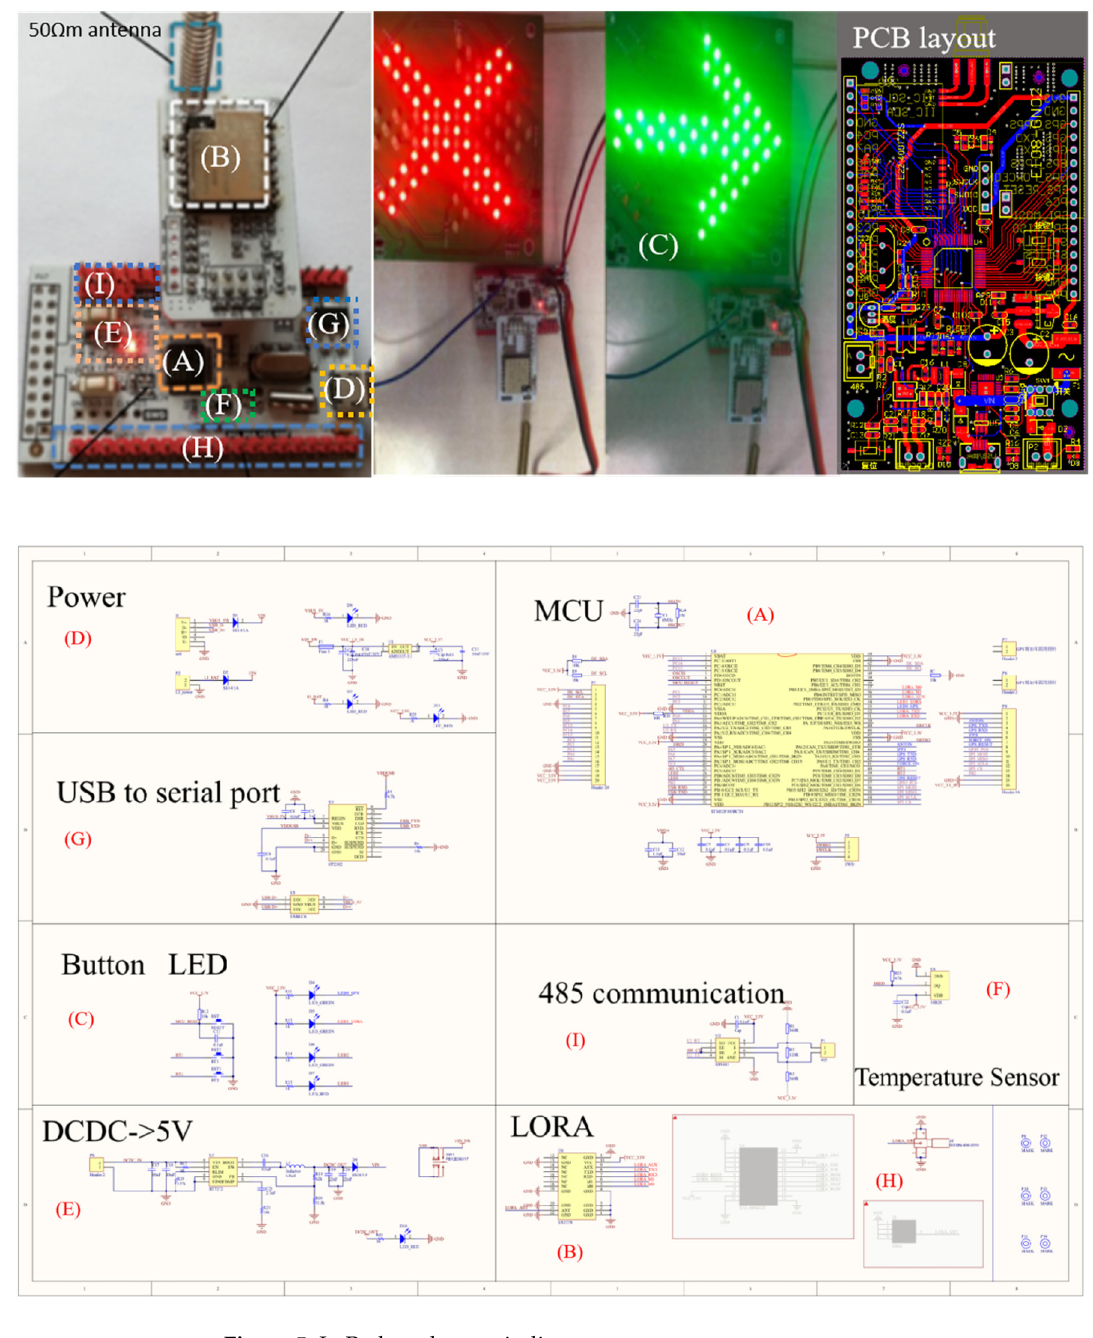
Figure 5. LoRa-based smart indicator